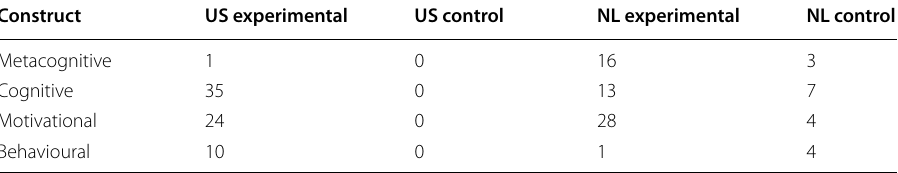
Table 5 Frequency of CQS constructs identified in Reflection Report data